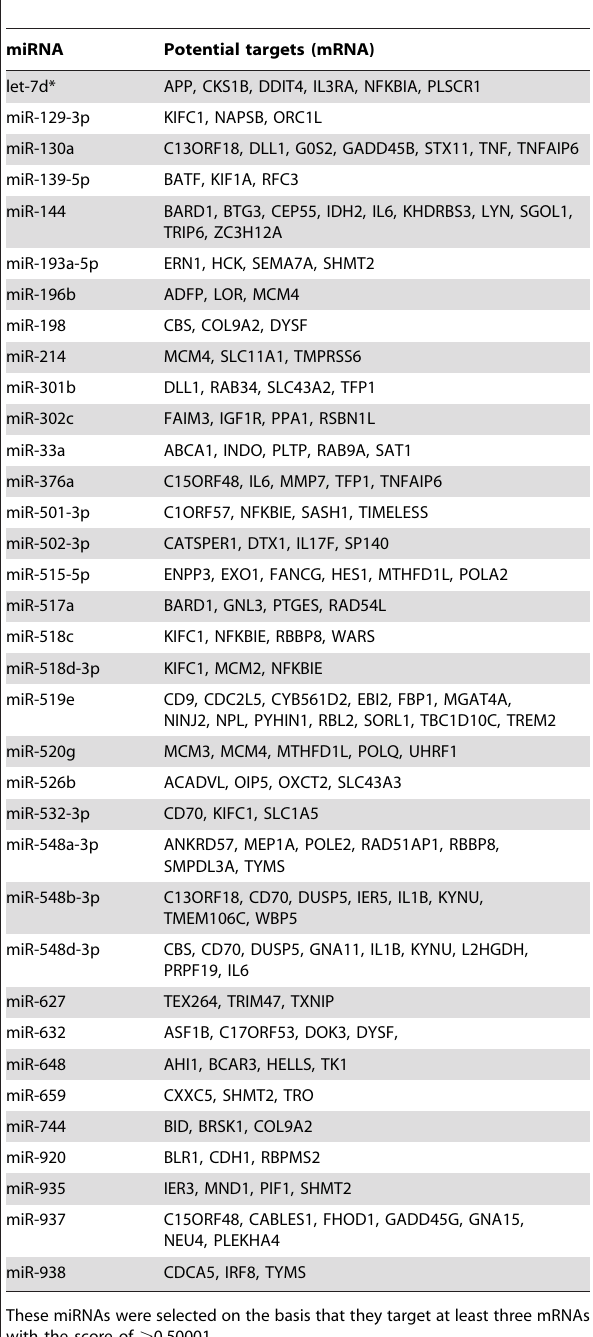
Table 5. Interplay between miRNA and mRNA based on GenMIR ++